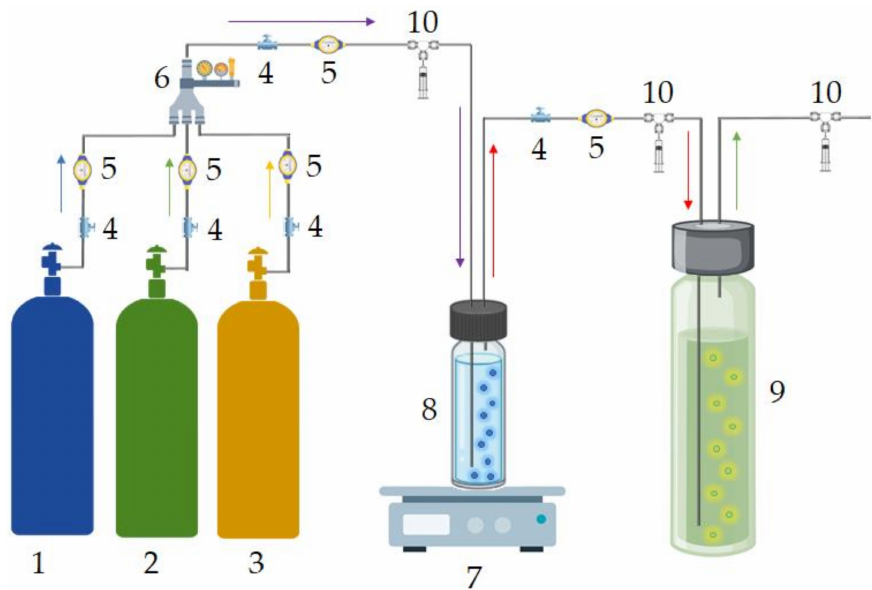
Figure 19. Siloxane absorption installation: 1-N 2 bottle; 2-CH 4 bottle; 3-CO 2 bottle; 4-valve; 5-flowmeter; 6-gas mixer; 7-hotplate; 8-vial with siloxanes; 9-vial with DES; 10-gas sample col- lection